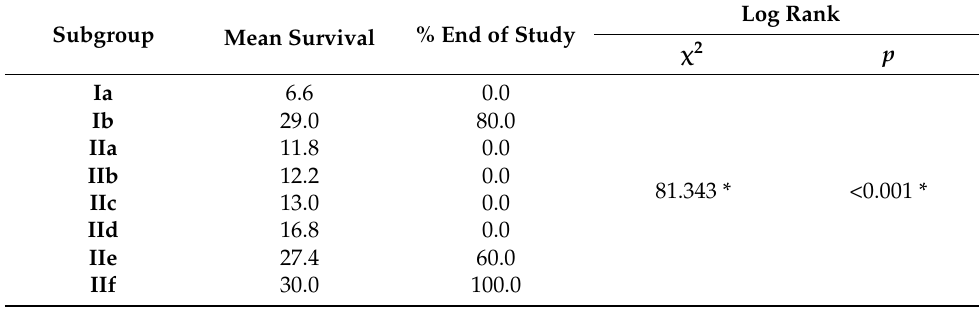
Table 2. Kaplan-Meier survival for all subgroups.